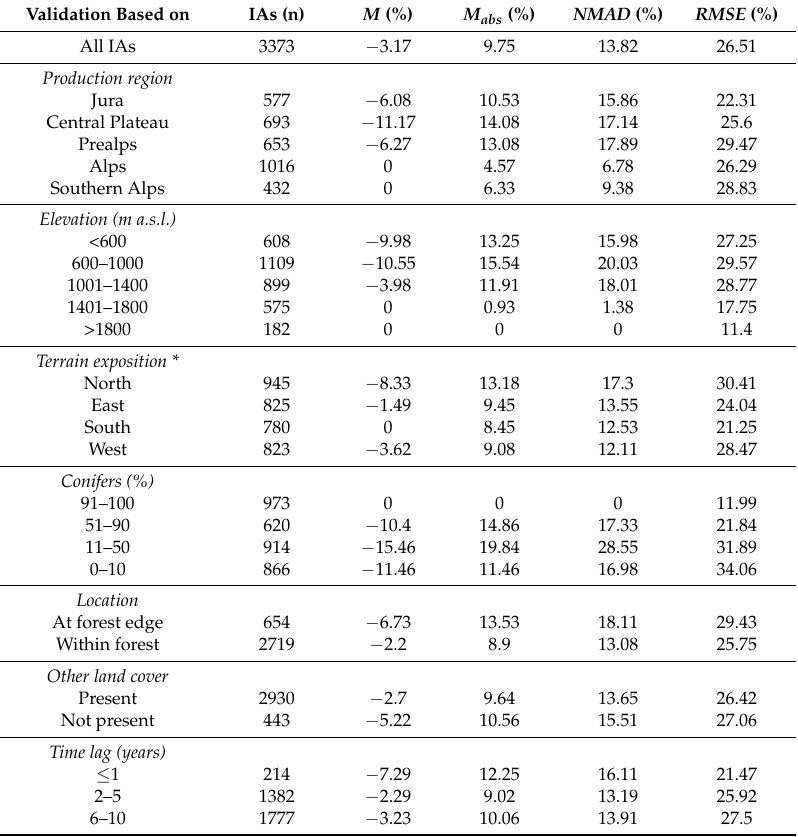
Table 5. Measurements of agreement in predicted and observed broadleaved fractions in the IAs using Median ( M ), absolute Median ( M abs ), Normalized Median Absolute Deviation ( NMAD ), and Root Mean Squared Error ( RMSE ). The validation incorporates all IAs, NFI production regions, NFI elevation levels, NFI stand composition (percentage of conifers), terrain exposition (aspect), location, and the presence of other land cover classes, and time